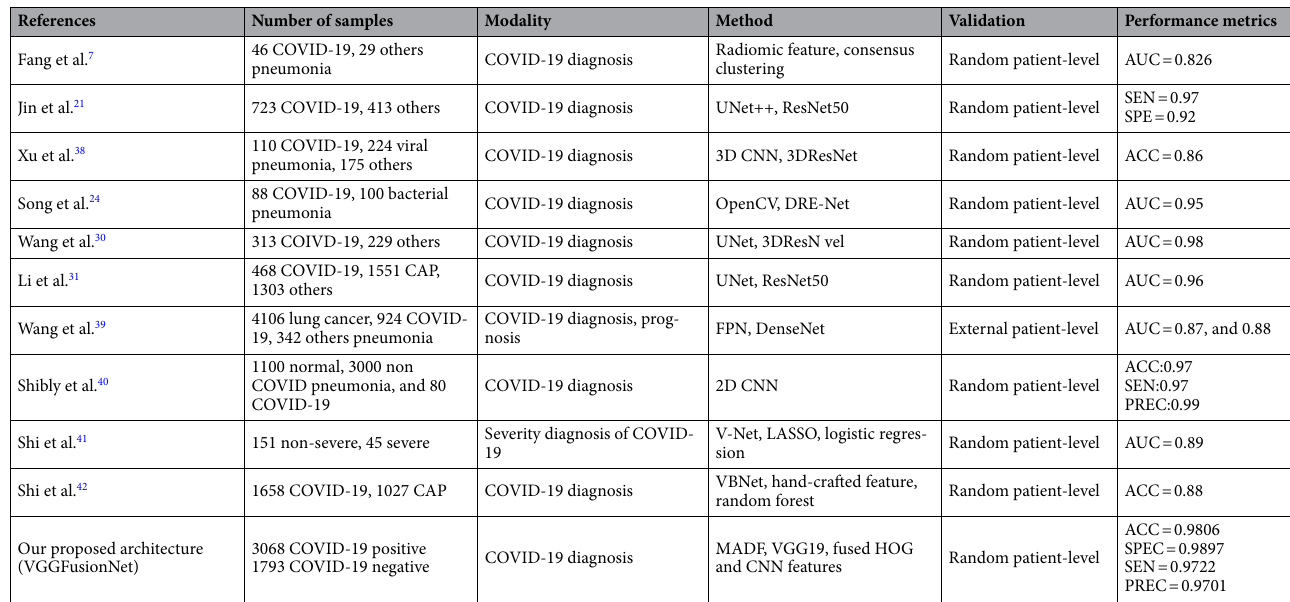
Table 5. An overview of relevant studies employing deep learning algorithms for COVID-19 case identification, as well as their working procedures and performance